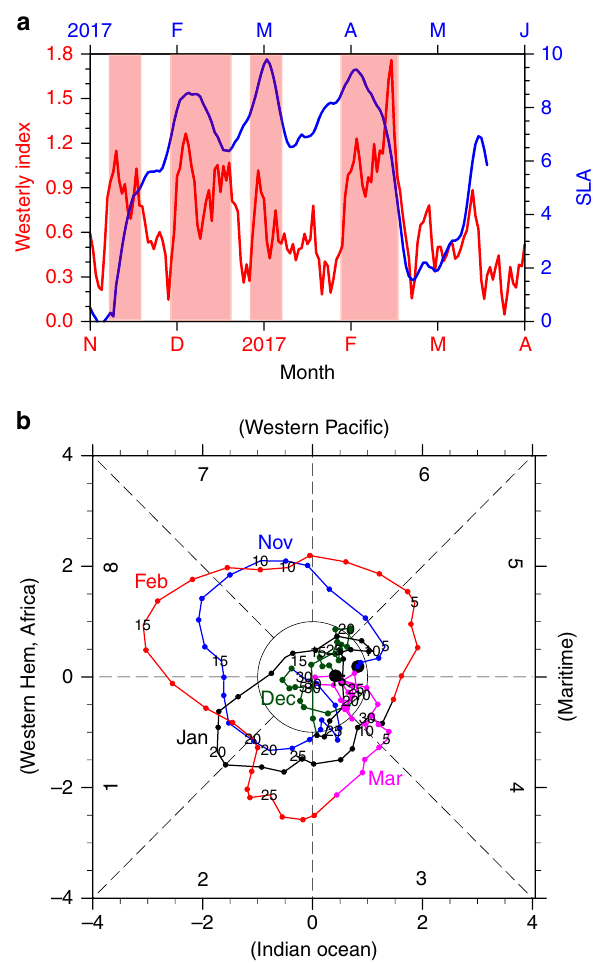
Fig. 6 Westerly wind events and MJO activities from November 2016 to March 2017. a Westerly index (m s − 1 ; red line; westerly wind anomalies averaged in the equatorial Paci fi c zonally and between 2 °S – 2 °N) and SLAs (cm; blue line, averaged in 85 °W – 95 °W, 2 °S – 2 °N). b The phase –